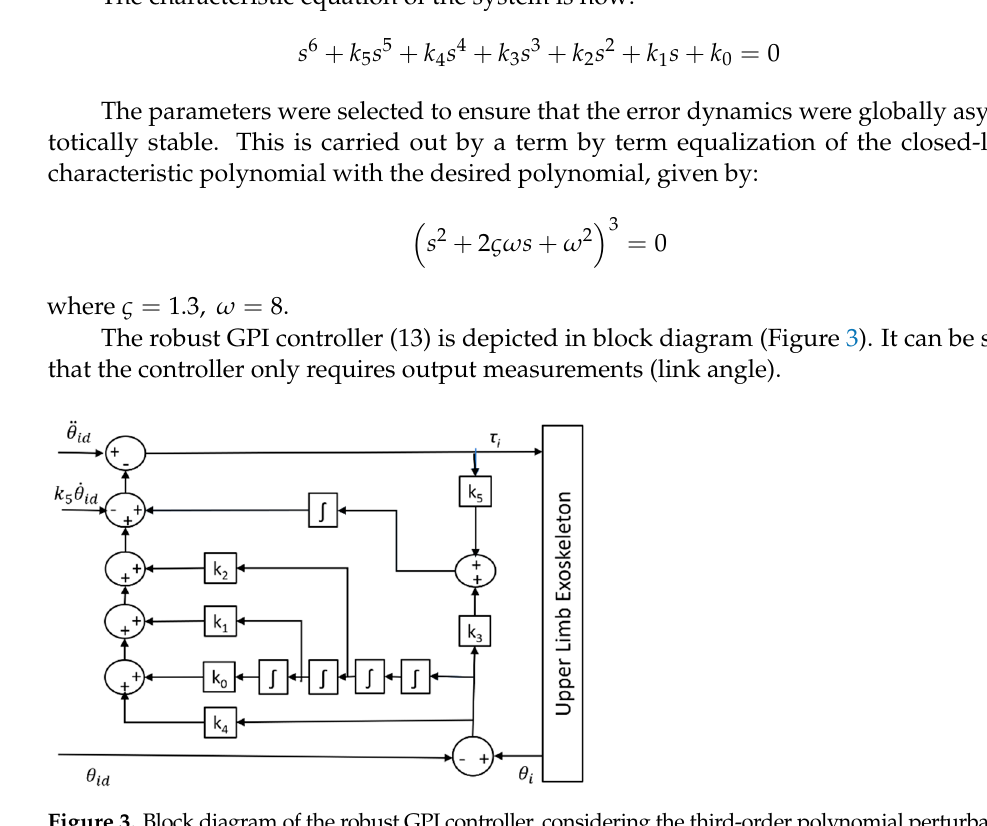
Figure 3. Block diagram of the robust GPI controller, considering the third ‐ order polynomial perturbation.